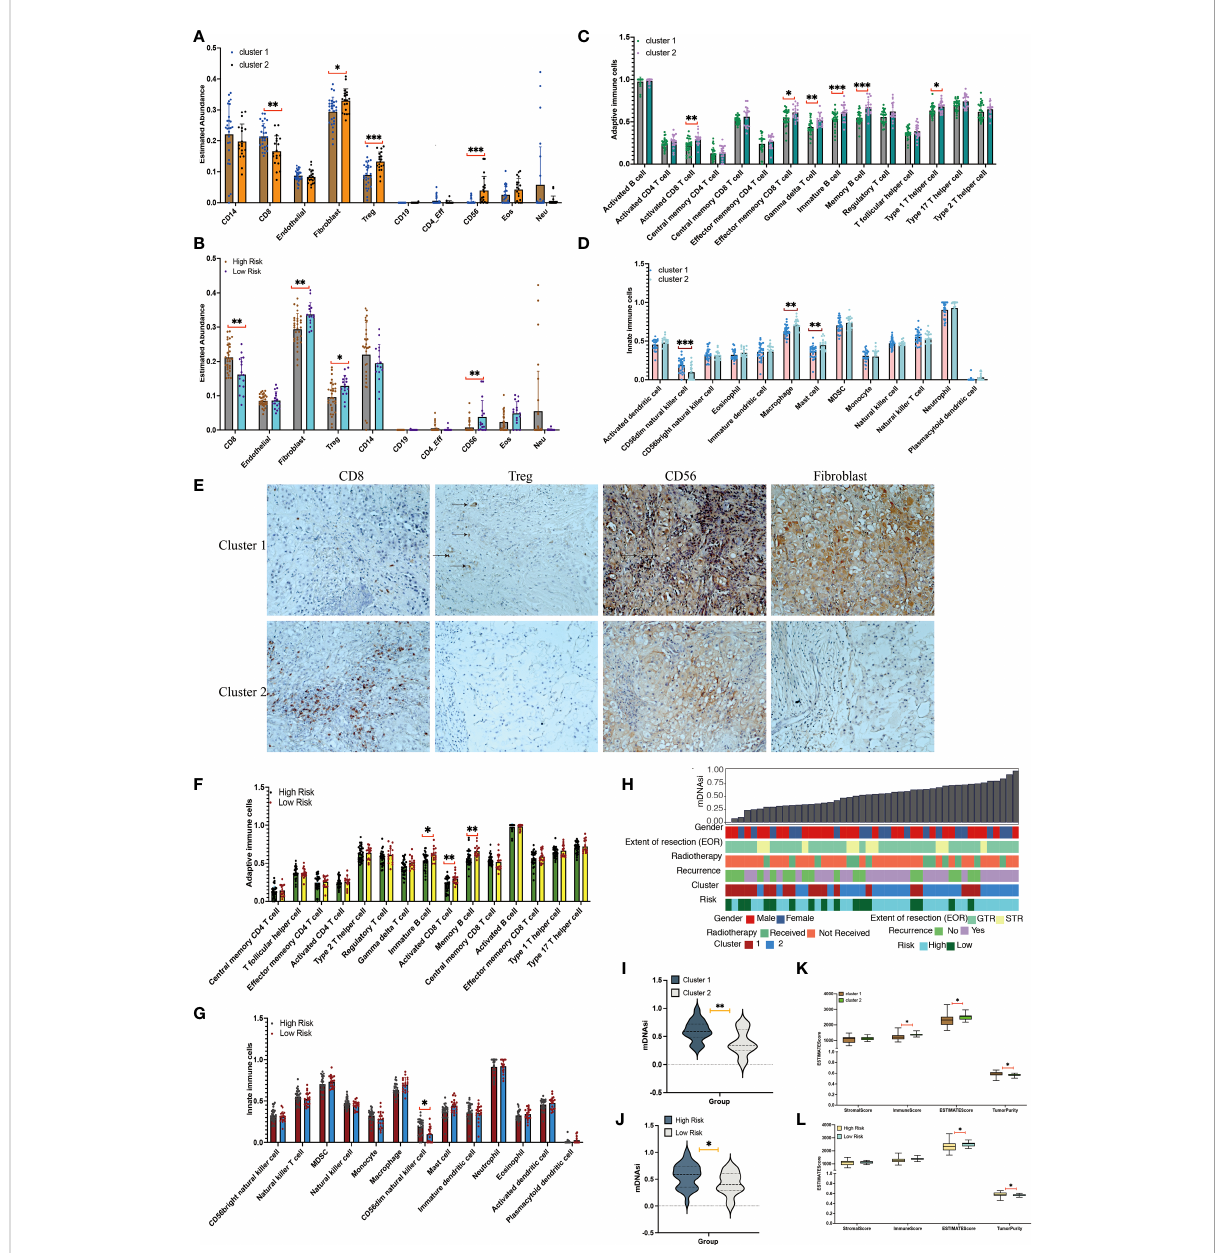
FIGURE 3 Immune cell in fi ltration and tumor microenvironment analyses between clusters. (A) Immune cell in fi ltration scores in cluster 1 and cluster 2 chordomas. (B) Immune cell in fi ltration scores in high-risk and low-risk chordomas. (C) Adaptive immune cells in cluster 1 and cluster 2 chordomas. (D) Innate immune cells in cluster 1 and cluster 2 chordomas. (E) Representative images (×20) showing more frequent presence of CD8, Treg, CD56, and fi broblasts in cluster 1 (upper panels) than cluster 2 (lower panels). (F) Adaptive immune cells in high-risk and low-risk chordomas. (G) Innate immune cells in high-risk and low-risk chordomas. (H) The association between known clinical and molecular features (sex, extent of resection [EOR], radiotherapy, recurrence status, cluster status, and risk status) and mDNAsi values of our cohort. Columns represent the sorted chordoma samples by mDNAsi values (low to high). Rows represent clinical information. (I) Violin plots of mDNAsi values in cluster 1 and cluster 2 chordoma patients. (J) Violin plots of mDNAsi values in the high-risk and low-risk chordoma patients. (K) Distribution of stromal scores, immune scores, ESTIMATE scores, and tumor purity of cluster 1 and cluster 2 chordoma patients. (L) Distribution of stromal scores, immune scores, ESTIMATE scores, and tumor purity of high-risk and low-risk chordoma patients (*** p < 0.001, ** p < 0.01, * p <